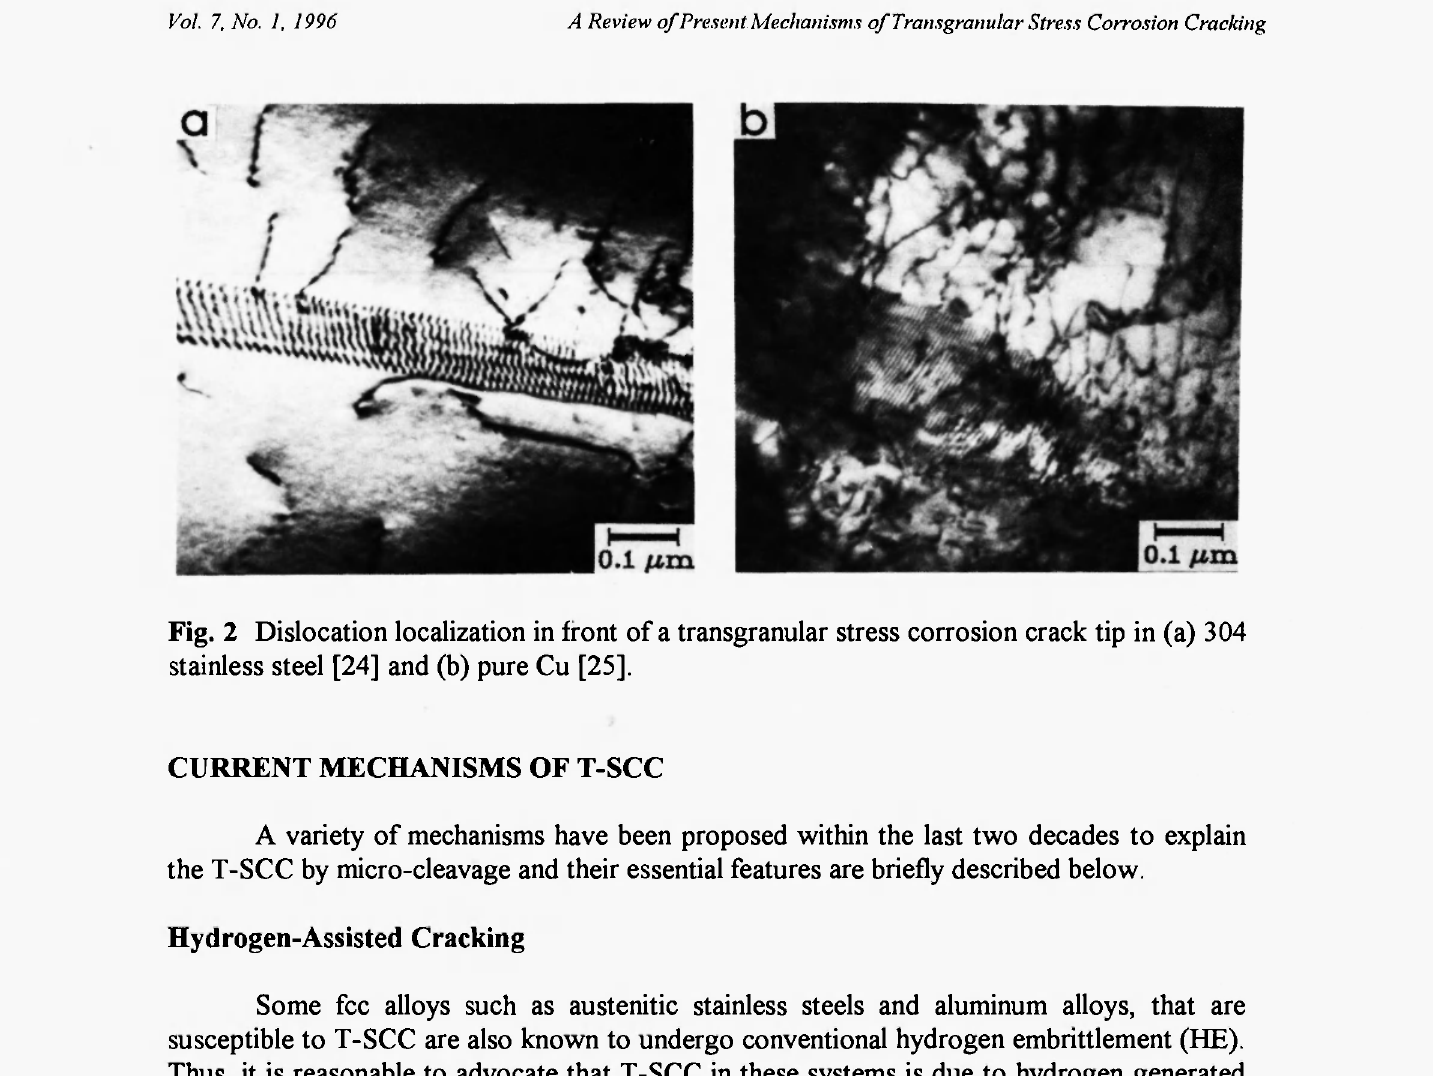
Fig. 2 Dislocation localization in front of a transgranular stress corrosion crack tip in (a) 304 stainless steel [24] and (b) pure Cu